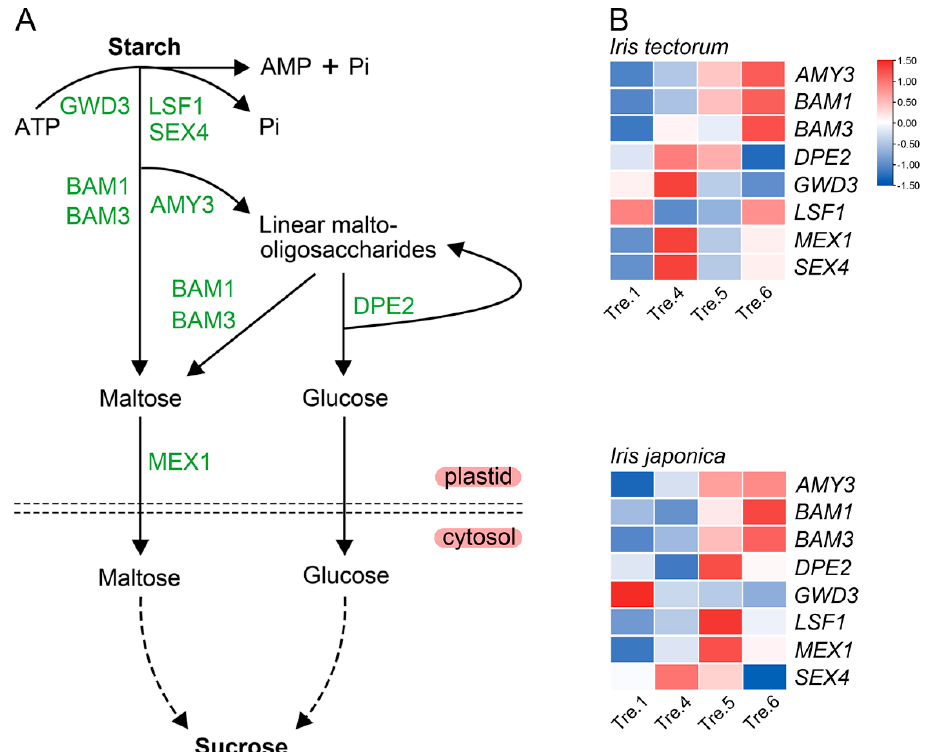
Figure 5. Transcript expression of genes associated with starch degradation pathways in Iris tectorum (IT) and I. japonica (IJ), under artificial dormancy induction conditions. ( A ) A schematic illustration of starch degradation pathways. ( B ) Transcript expression of genes associated with starch degradation pathways in IT and IJ under artificial dormancy induction conditions. Red denotes that the gene is upregulated, whereas blue represents that the gene is downregulated. Gene full names are shown in Supplemental Table S1.